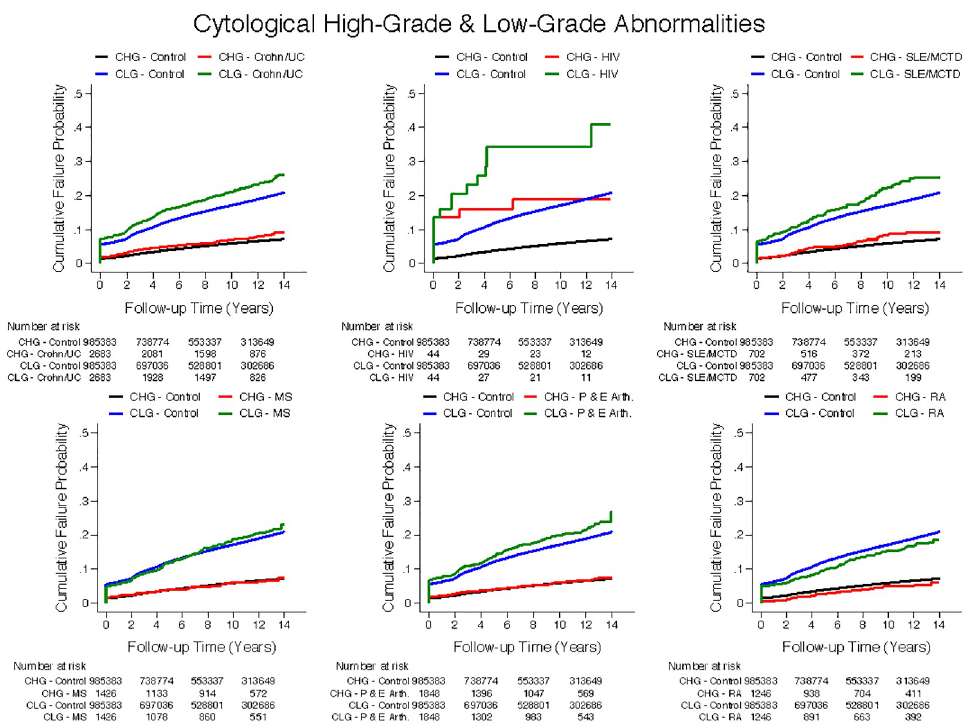
Fig 2. Cumulative incidence of cytological high-grade and low-grade abnormalities. Cumulative incidence of cytological high grade (CHG) and Cytological low grade (CLG) abnormalities compared to healthy controls in a) Crohn’s disease/Ulcerative colitis. b) HIV c) SLE/MCTD d) MS e) PsA and EA and f) RA. UC = Ulcerative colitis; HIV = Human immunodeficiency virus; SLE/MCTD = Systemic Lupus Erythematosus/ Mixed Connective Tissue Disease; MS = multiple sclerosis; P&E = psoriatic arthritis and enteropathic arthropathy; RA = Rheumatoid arthritis.